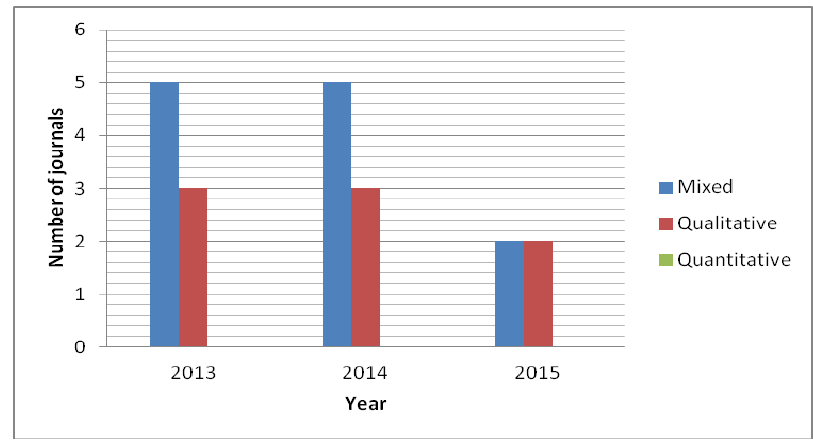
Figure 3. Frequency of research methods in each